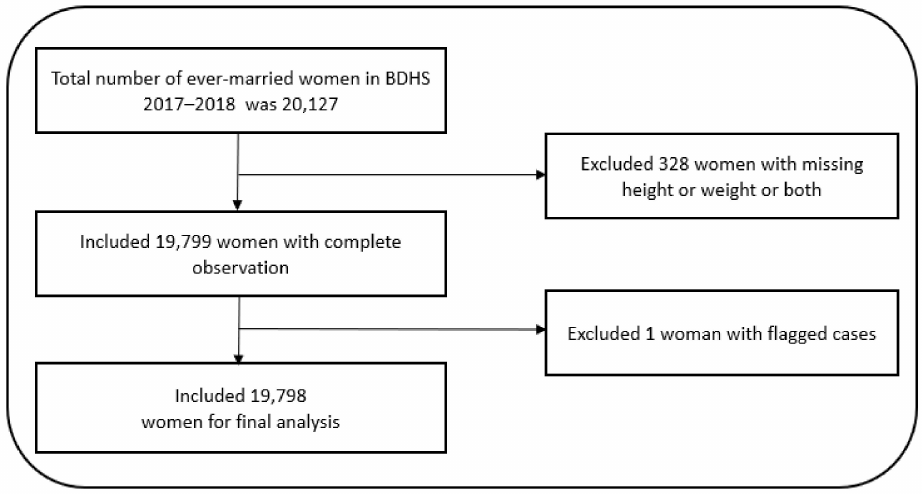
Figure 1. Flow-chart, selection of study